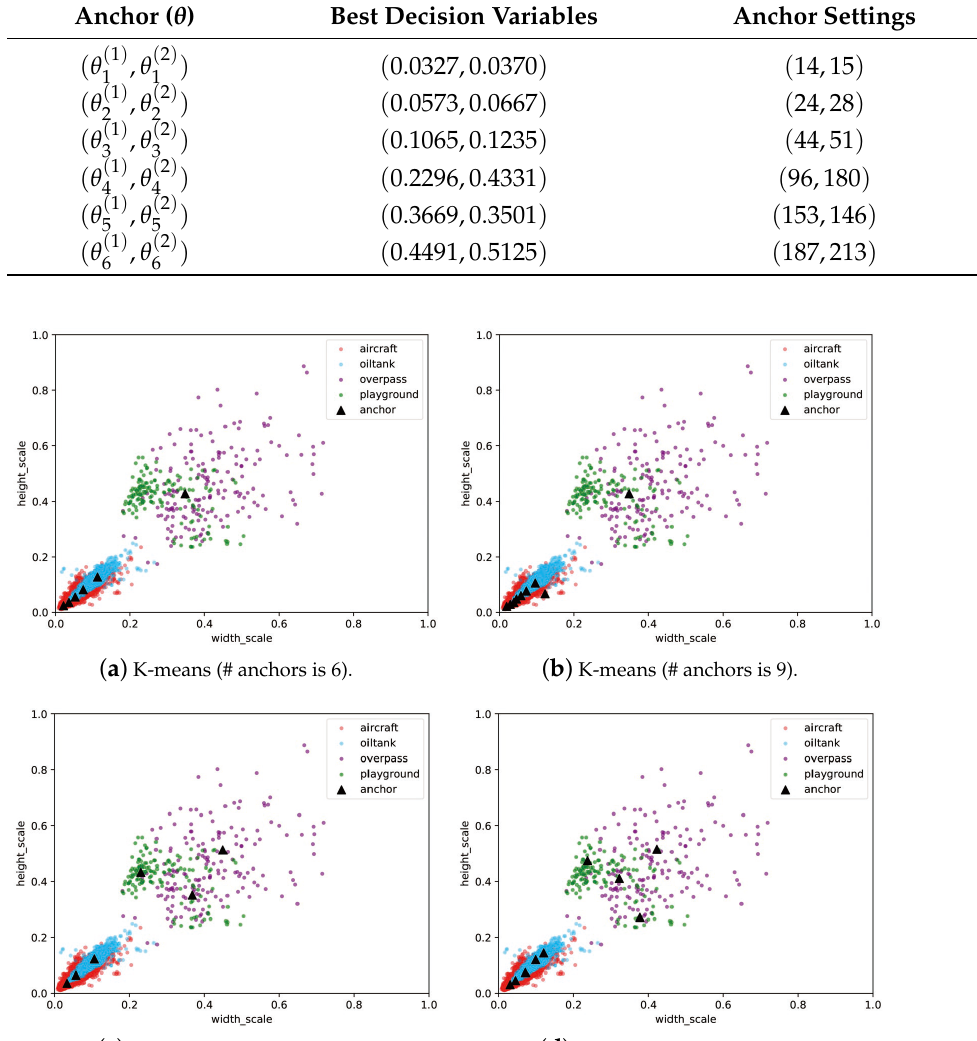
Table 7. Best anchors (two prediction-layer setting) obtained by the proposed scheme.